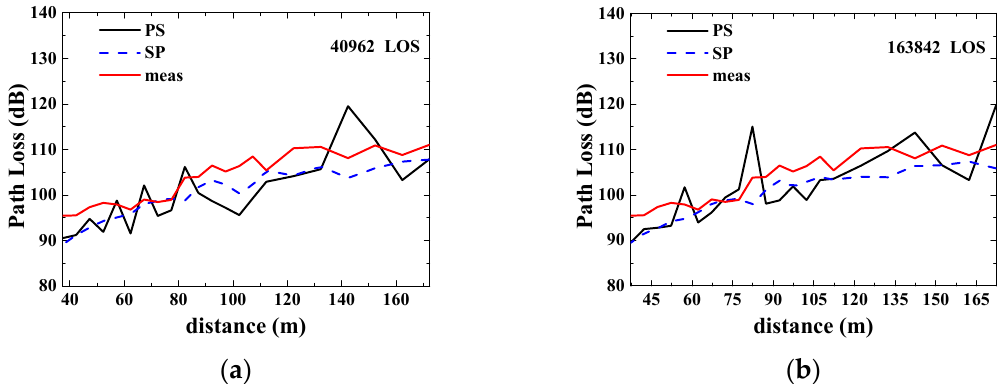
Energies 2021 , 14 , x FOR PEER REVIEW Figure 12. Path loss comparison of theoretical calculation with measured data for 40,962 and 163,482 rays in the LOS. ( a ) The number of rays is 40,962 ( b ) The number of rays is 163,482.